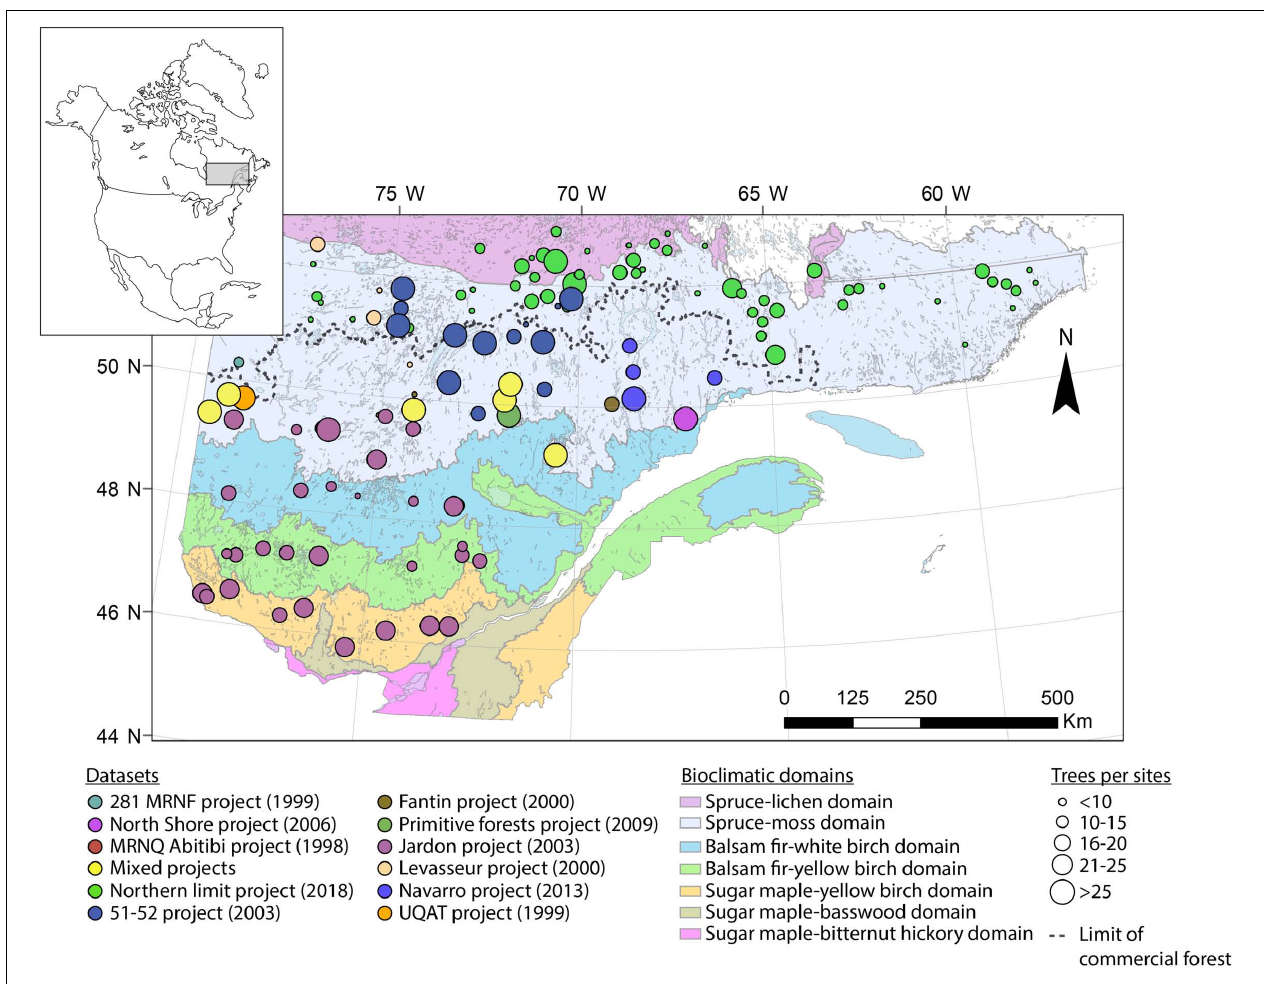
FIGURE 1 | Location of study sites in Quebec (Canada). The different colors correspond to the various original datasets.